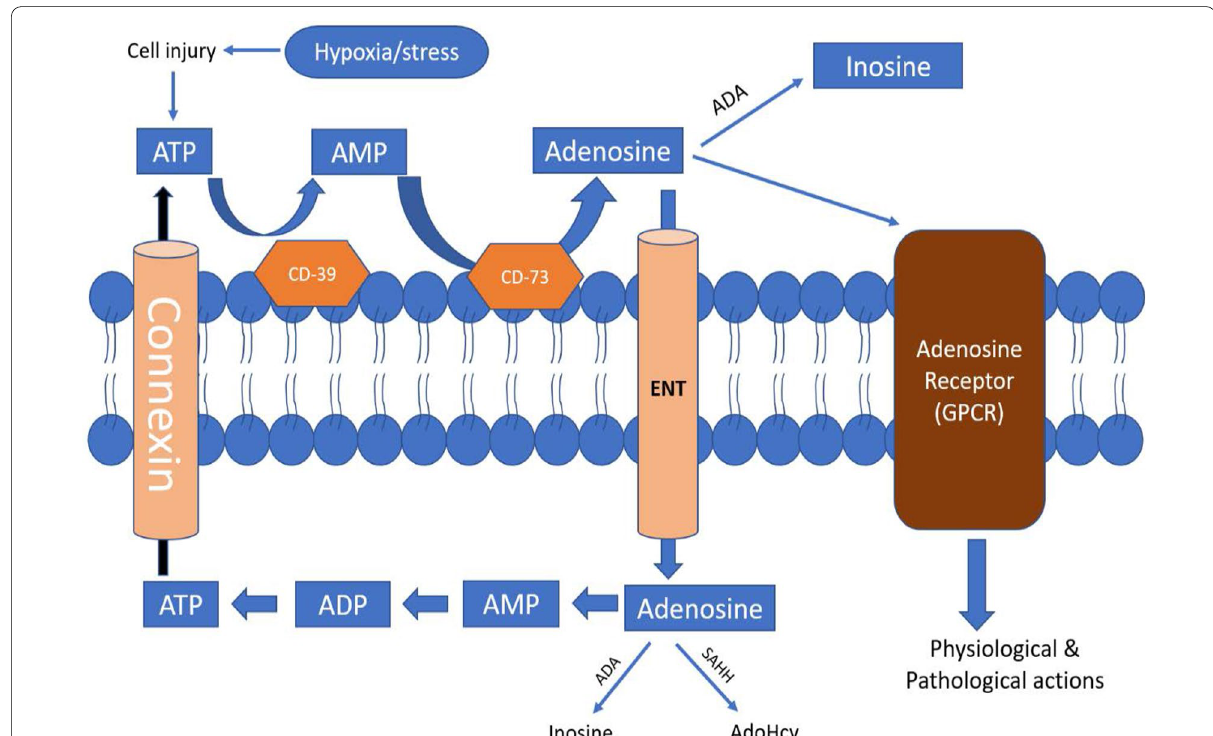
Fig. 2 Catabolism of ATP and formation of